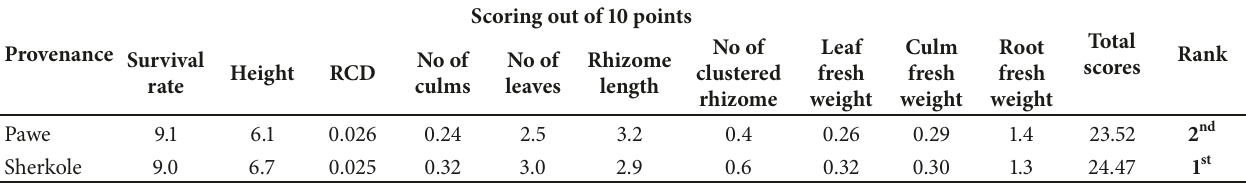
Table 5: Provenances of O. abyssinica seedlings suitability index evaluation.